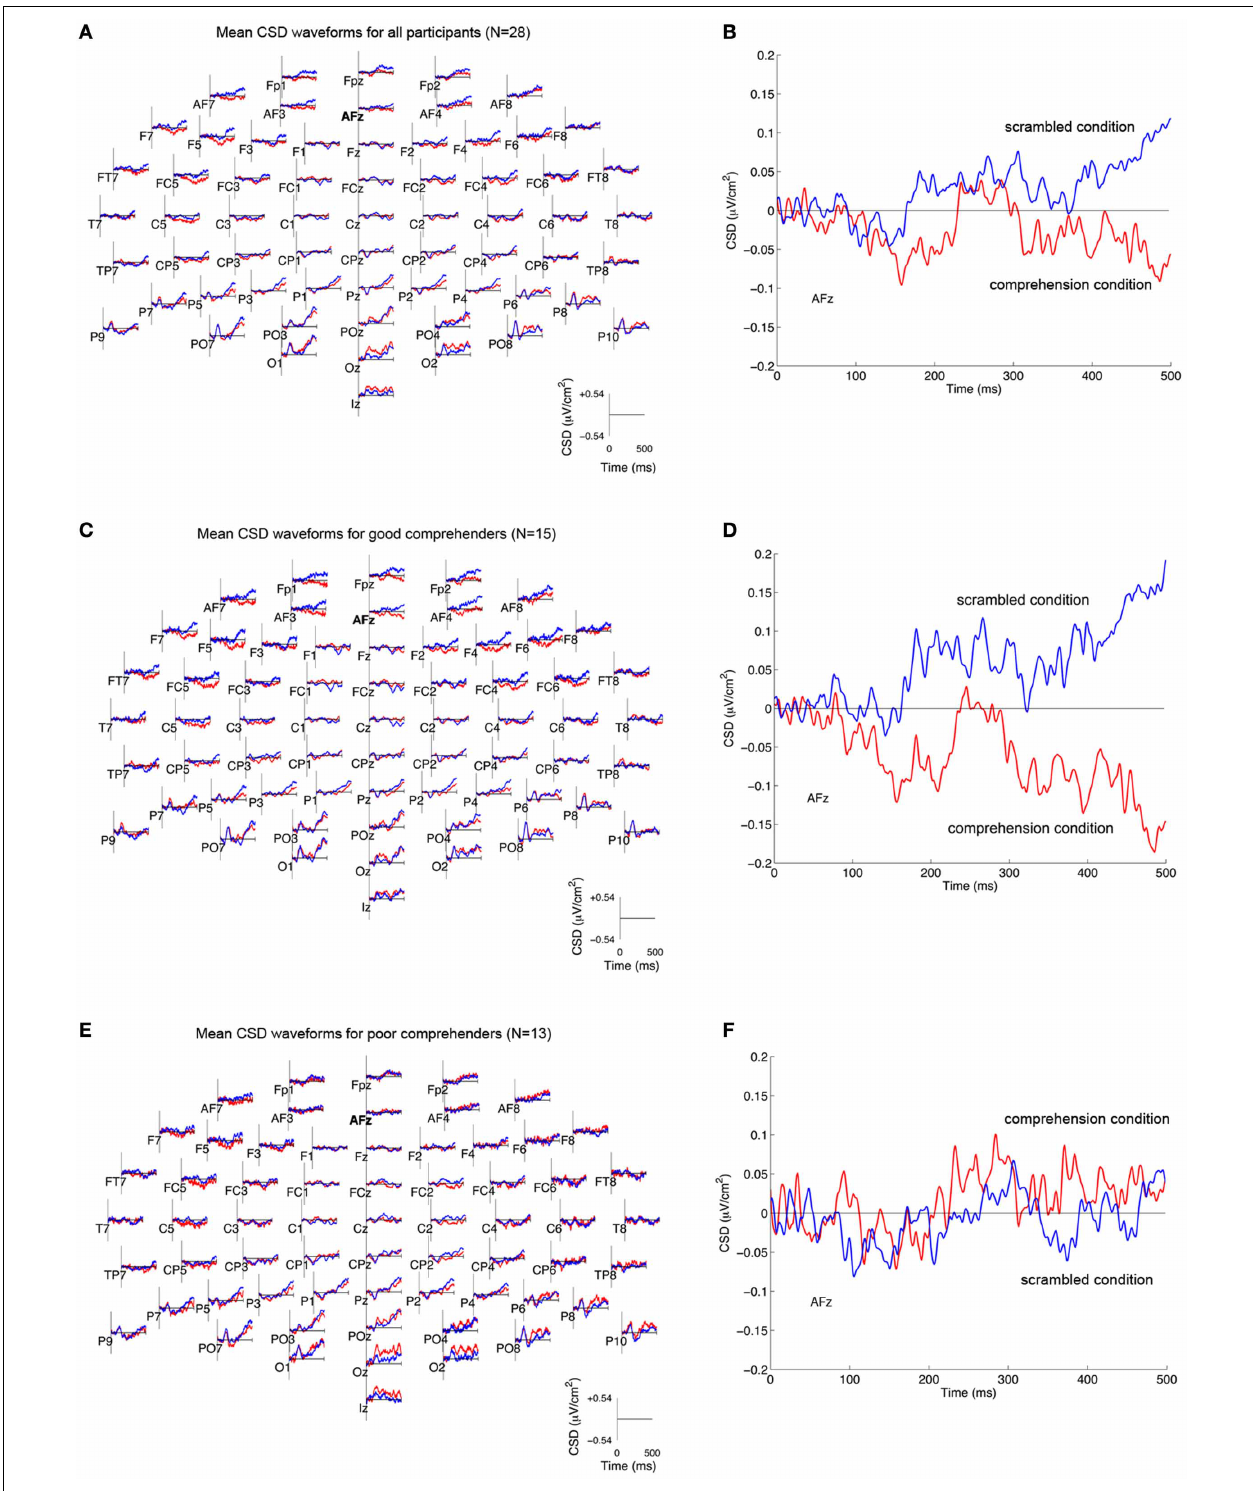
FIGURE 3 | Mean CSD-transformed ERP waveforms in the scrambled and comprehension conditions. (A) CSD-transformed ERP waveforms (in µ V/cm 2 ) at each of 64 scalp sites time-locked to the onset of the target word (“and”) in the scrambled condition (blue) and the comprehension condition (red) for all participants ( N = 28). Current sources are plotted as positive values, and current sinks as negative